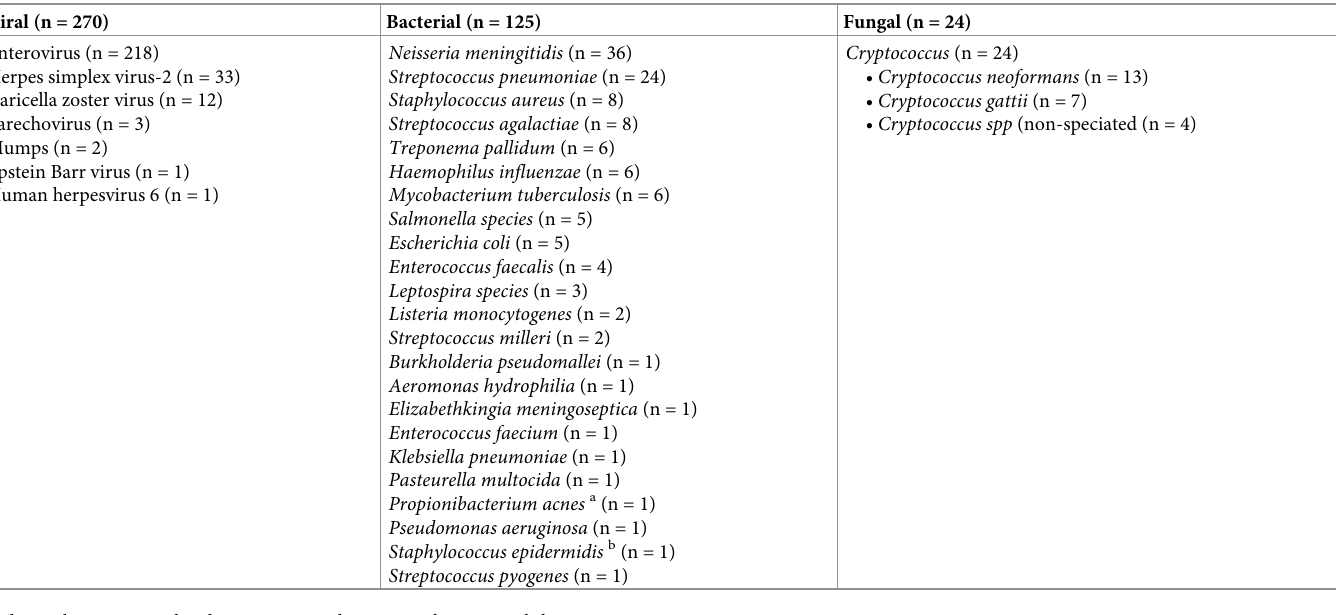
Table 5. Laboratory-confirmed aetiology of patients with meningitis.